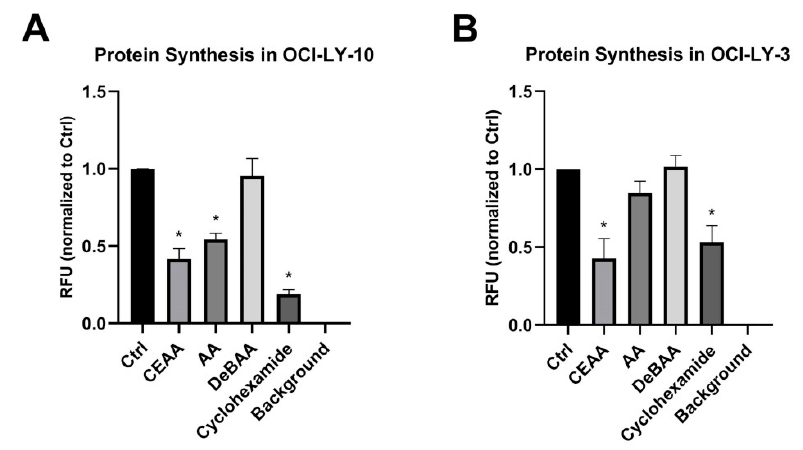
Figure 7. Chloro-ethyl agelastatin A (CEAA) significantly inhibits protein synthesis in two diffuse large B-cell lymphoma cell lines. ( A ) Protein synthesis, incorporation of O-propargyl-puromycin (OPP), was reduced with CEAA (1 µ M) and Agelastatin A (AA, 1 µ M) treatment of OCI-LY-10 cells compared to DMSO (Ctrl). A similar inhibition was not observed with an in-active AA analogue (DeBAA, 1 µ M). Cyclohexamide (1 µ M), a known translation inhibitor, was used as a positive control. ( B ) Similar results were observed in OCI-LY-3 cells, but AA treatment did not effectively reduce protein translation. Experiments were done in triplicate. Error bars represent SEM; * indicates p ≤ 0.05.